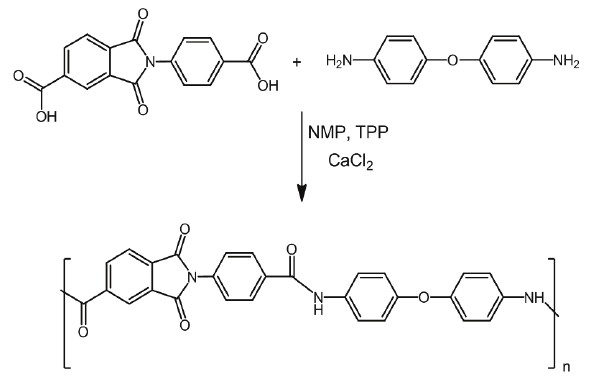
Figure 2. Synthetic route of PAI 5 . Figure 3. Flow sheet diagram for the synthesis of PAI- nanocomposites film 5a and 5b